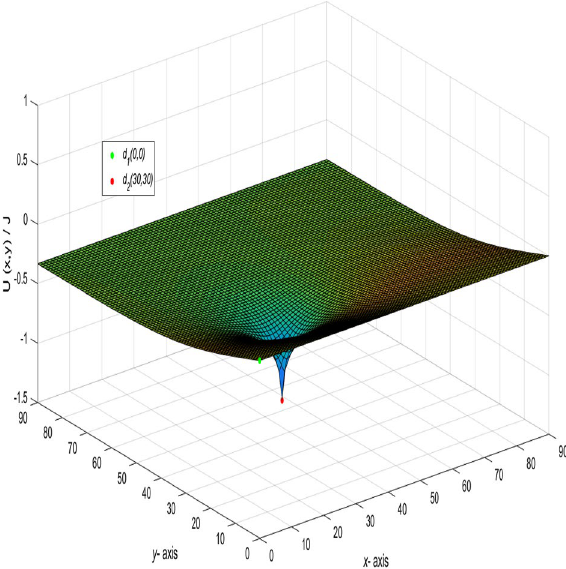
Figure 5. The process of forming a 3D dynamic view for U 90